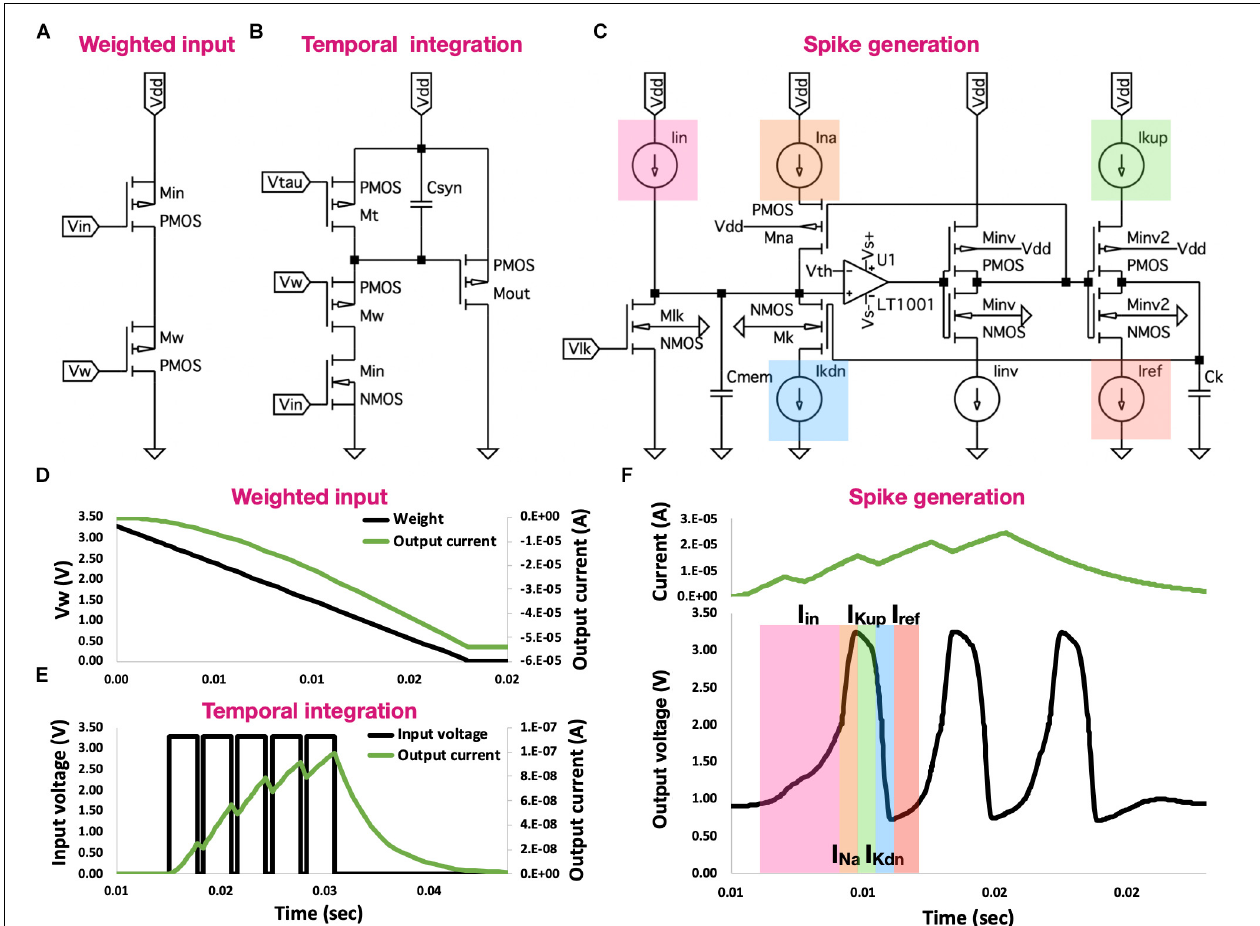
FIGURE 1 | Neuron building blocks. (A) Pulse current source synapse. This voltage-controlled current source is activated by an active-low input spike, producing a current, which follows the input voltage pattern and dynamic. (B) Subthreshold first-order LPF circuit. This circuit provides temporal control of both charging and discharging of a capacitor, allowing for temporal integration of incoming spikes. (C) Voltage-amplifier LIF neuron. This spike generating circuit provides precise control of the generated spikes, including spikes’ rise time, width, fall time, and refractory period. (D) Signal traces for the current-source synapse. When spike arrives (synapse is activated-low; V in ), current I syn is proportionally generated. This synapse offers magnitude control where I syn is proportionally correlated to V w . (E) Signal traces for the log-domain integrator synapse. Log-domain integrator synapse features a linear integration of incoming spikes, where ahead of saturation, each spike equally contributes to I syn . (F) Signal traces for the voltage-amplifier LIF neuron. Neuron is driven by I in , which was generated by the subthreshold first-order LPF circuit (described earlier). Circuit has two voltage inverters: first inverter I inv drives current I NA , and second inverter I inv drives the I K currents. 1 2